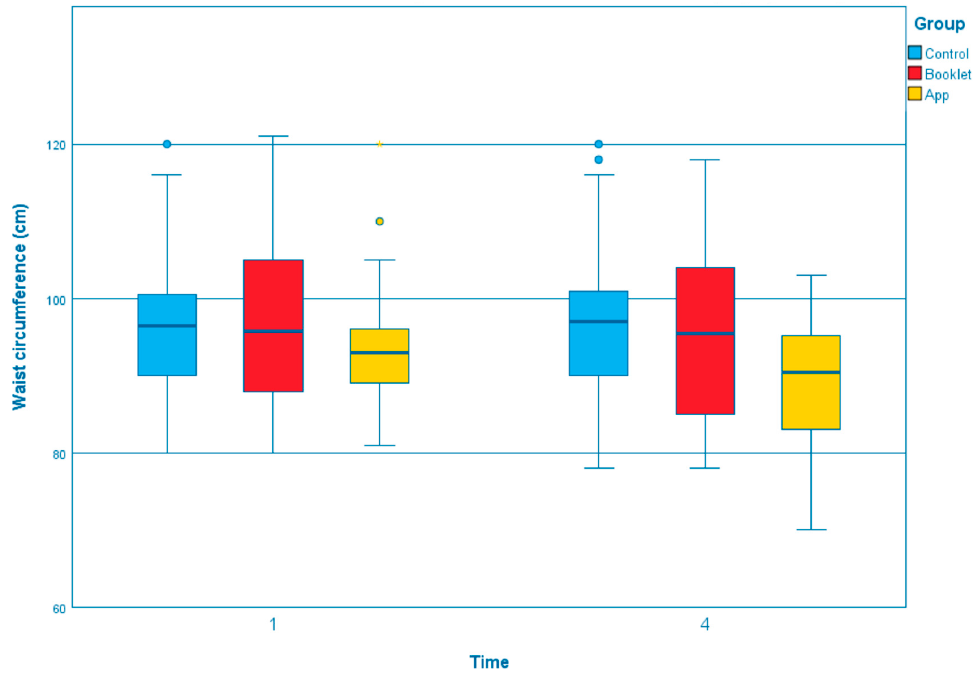
Figure 3. Boxplot of the change of waist circumference at different time point among the groups.